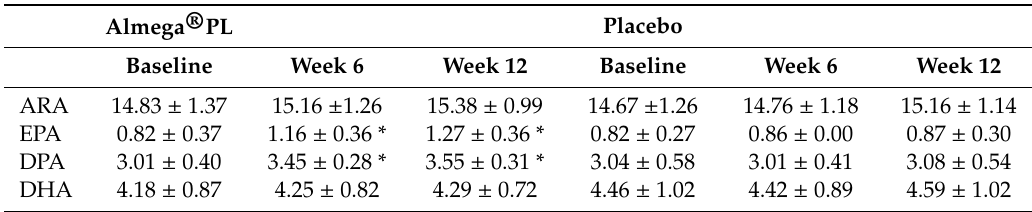
Figure 2. Omega-3 Index, or EPA + DHA % of total erythrocyte fatty acids, measured at baseline, week 6, and week 12. Values represented as mean ± SD, * change from baseline (Δ values) significantly different between groups, p < 0.05. Table 2. Erythrocyte arachidonic (ARA), eicosapentaenoic (EPA), n-3 docosapentaenoic (DPA) and